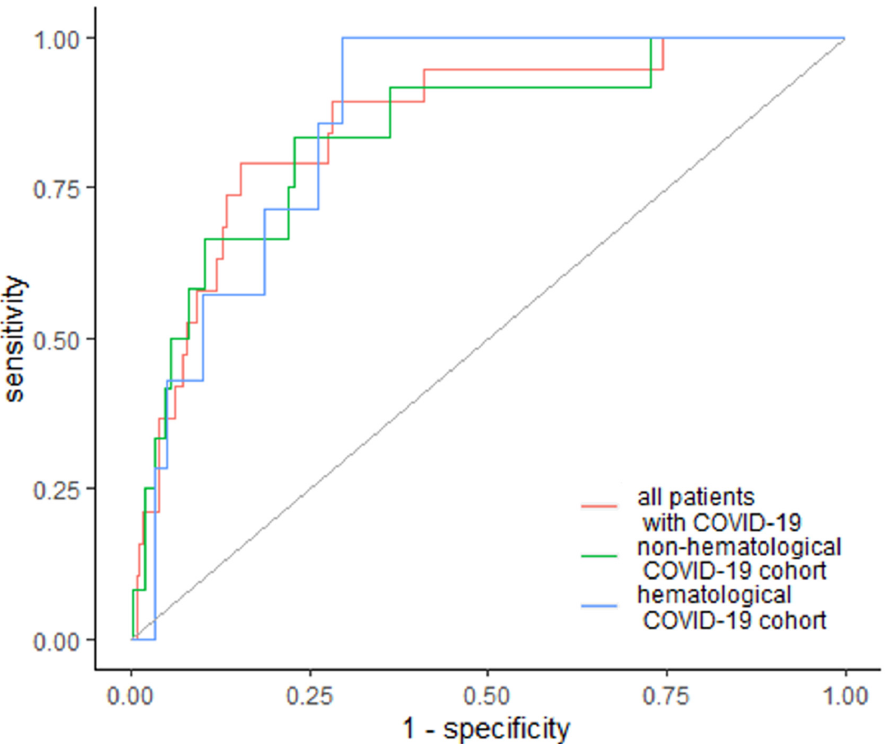
Figure 2. EASIX as a predictor of renal dialysis. Diagonal grey line represents random classifier (false positive rate = true positive rate).